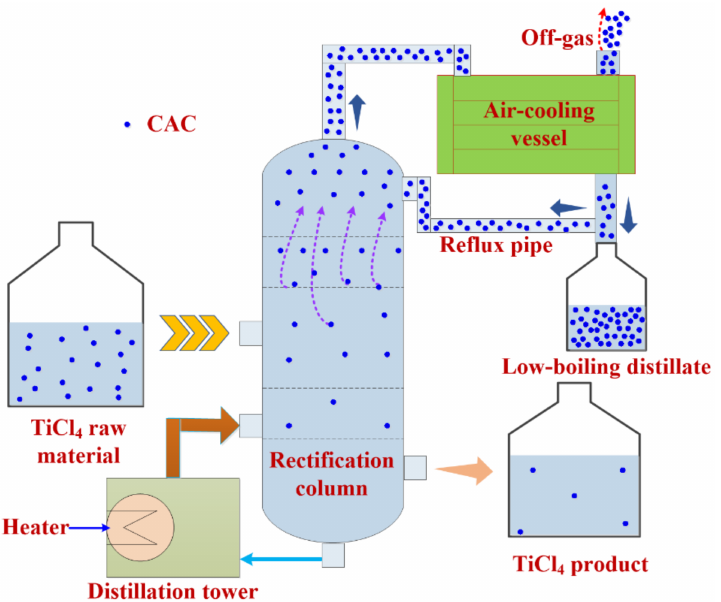
Figure 2. Schematic illustration of the TiCl 4